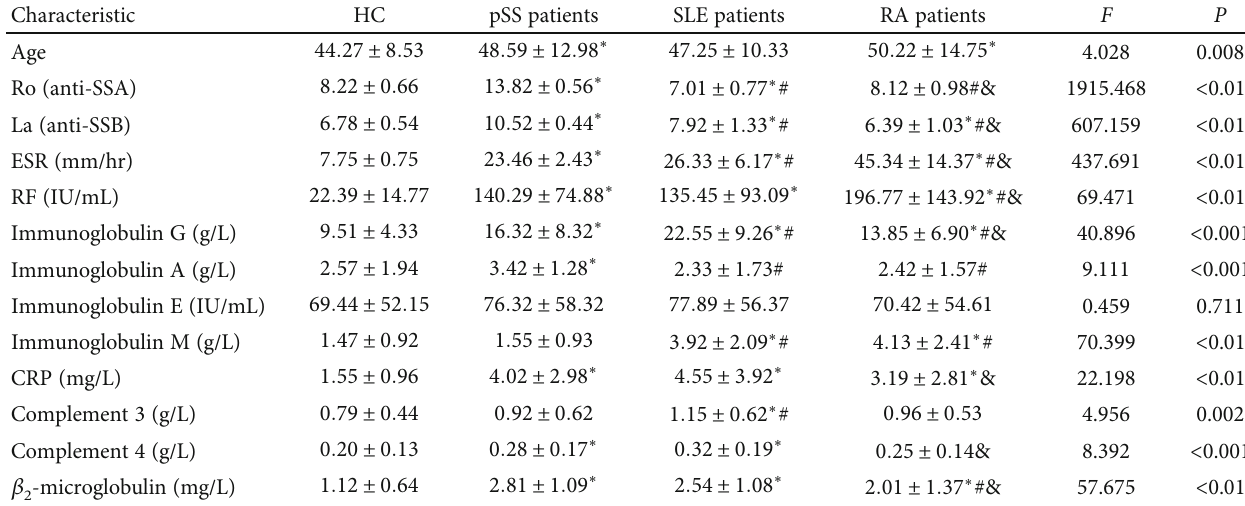
Table 2: The results of clinical characteristics in HC, pSS, SLE, and RA patients.